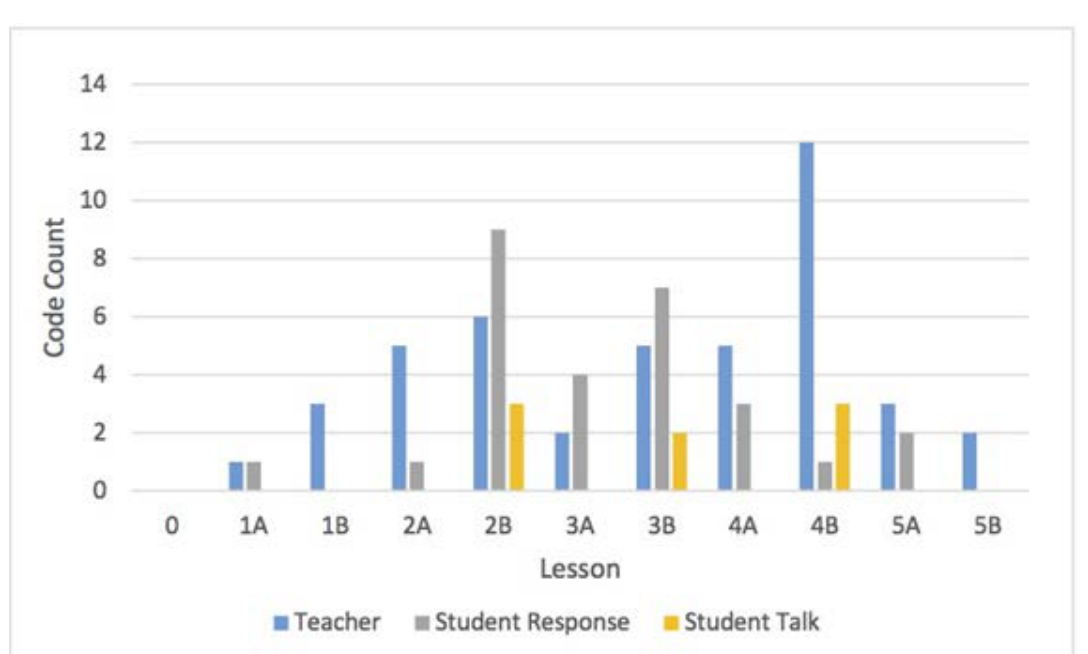
Figure 6. Instances where earlier lessons from the unit were recalled during later